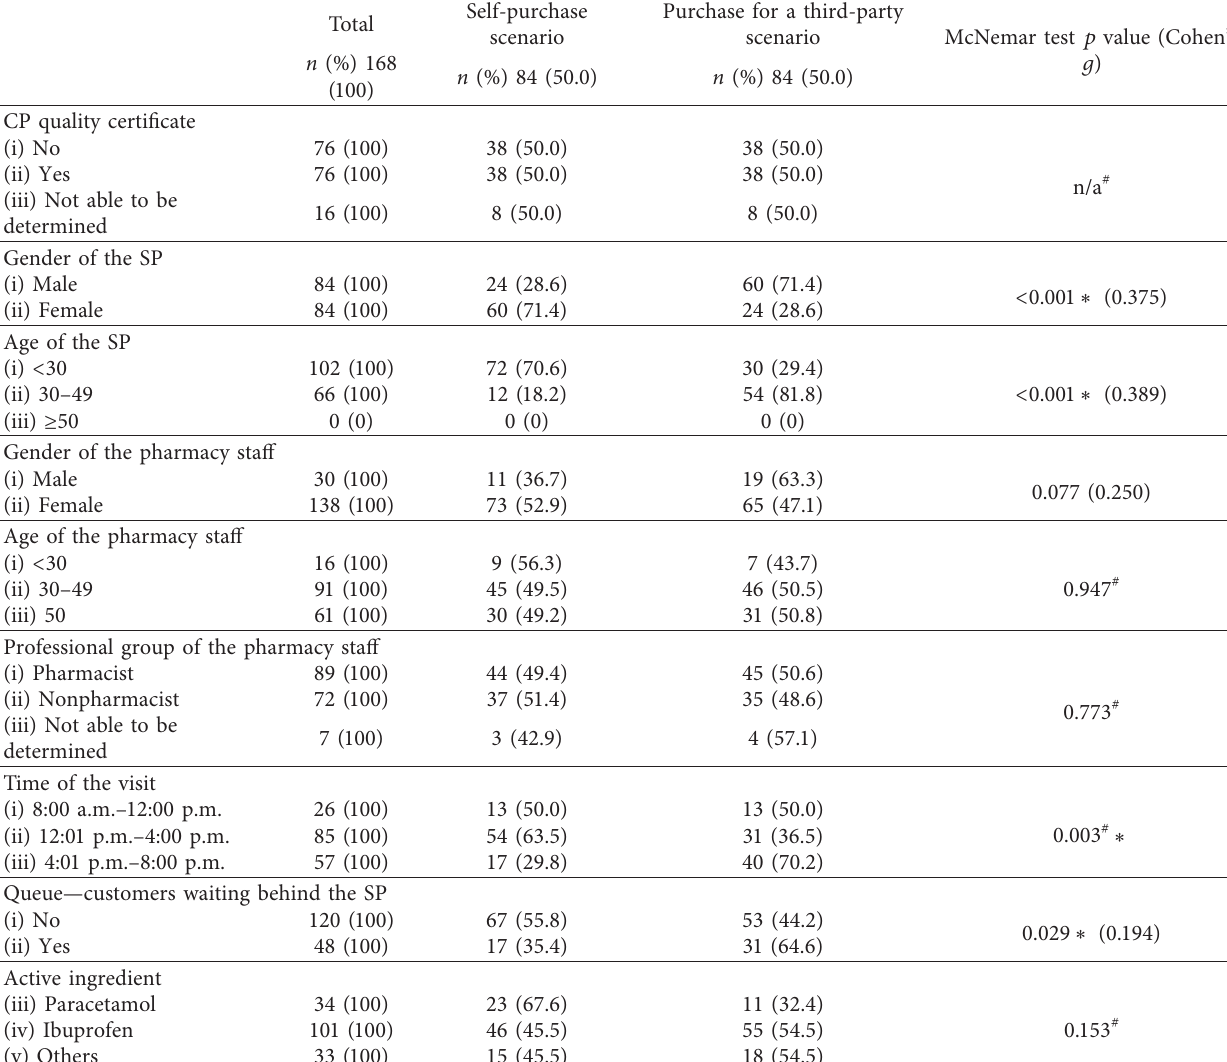
Table 5: CPs, SPs, pharmacy staff, visits, and active ingredients characteristics by scenario